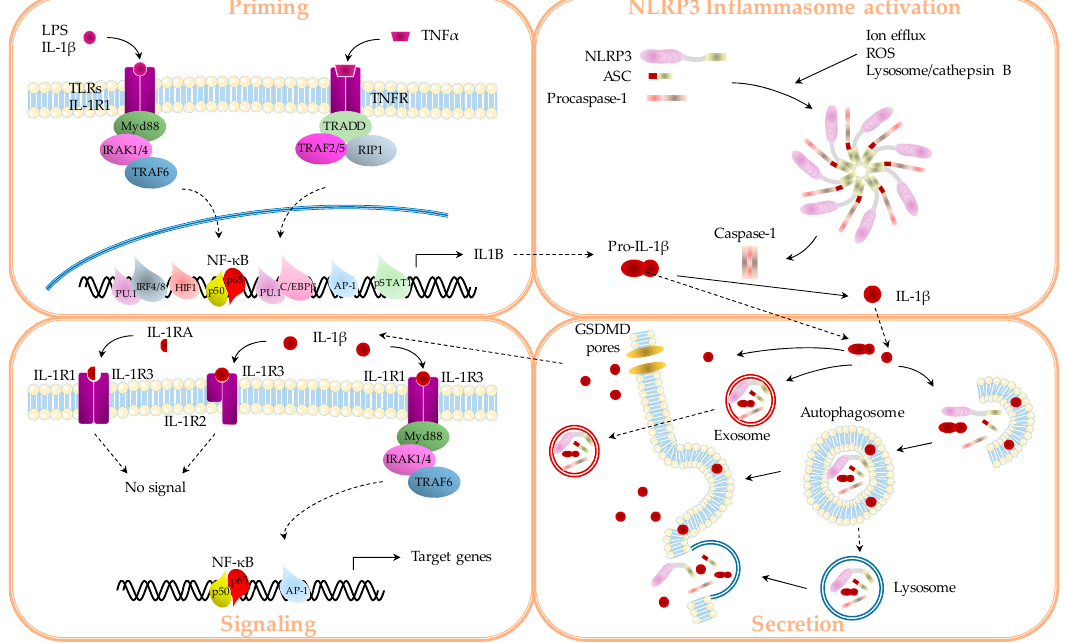
Figure 1. Di ff erent steps of interleukin (IL)-1 β production and signaling: priming, NOD-LRR and pyrin containing protein 3 (NLRP3) inflammasome activation, secretion, and signaling. LPS, lipopolysaccharides; TLR, toll-like-receptor; TNF, tumor necrosis factor; TNFR, TNF receptor; TRADD, TNFR1-associated death domain; RIP, receptor interacting protein; IRAK, interleukin-1 receptor-associated kinase; Myd, myeloid di ff erentiation primary response; TRAF, TNFR-associated factor; ASC, apoptosis associated speck-like protein containing a CARD domain; GSDMD, gasdermin D; ROS, reactive oxygen species; NF- κ B, nuclear factor kappa-light-chain-enhancer of activated